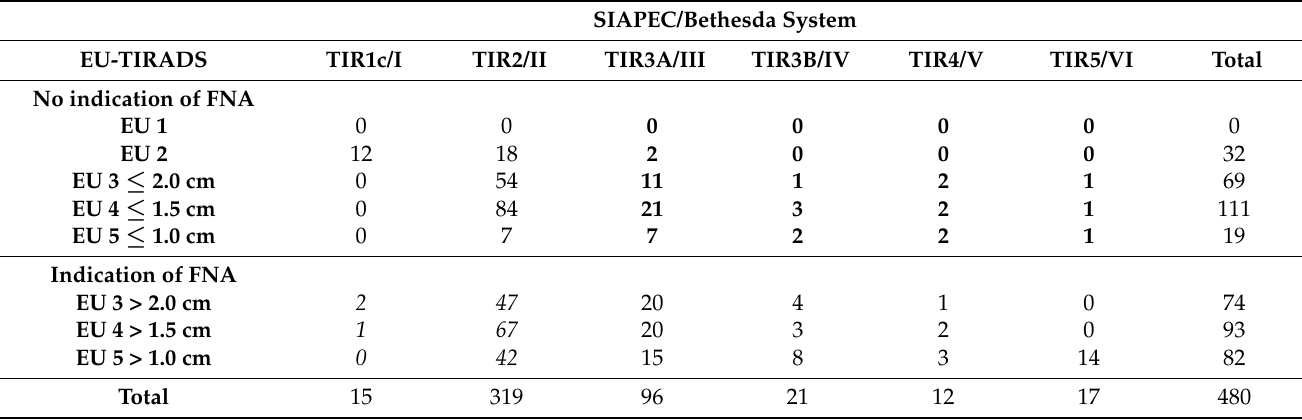
Table 3. EU-TIRADS vs. SIAPEC/Bethesda system cytological classifications. False negative cases are in bold. False positive cases are in